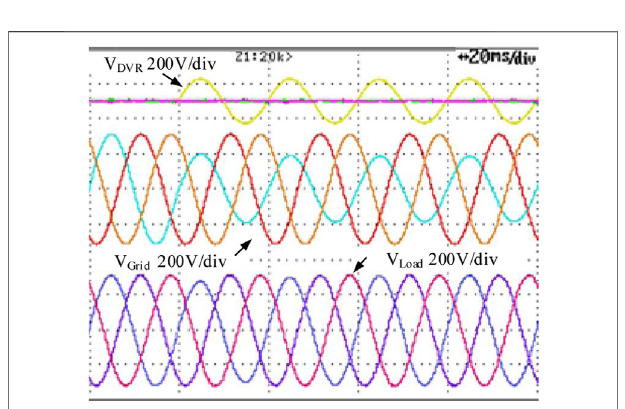
FIGURE 14 | Experimental results of single-phase voltage sag compensation.